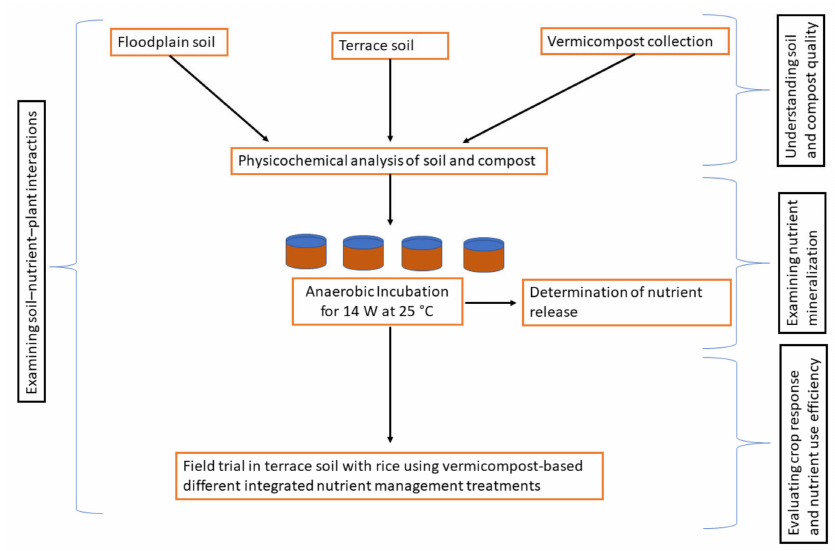
Figure 1. Flow-diagram of experimental methodology from soil and vermicompost sample collection to field experimentation.